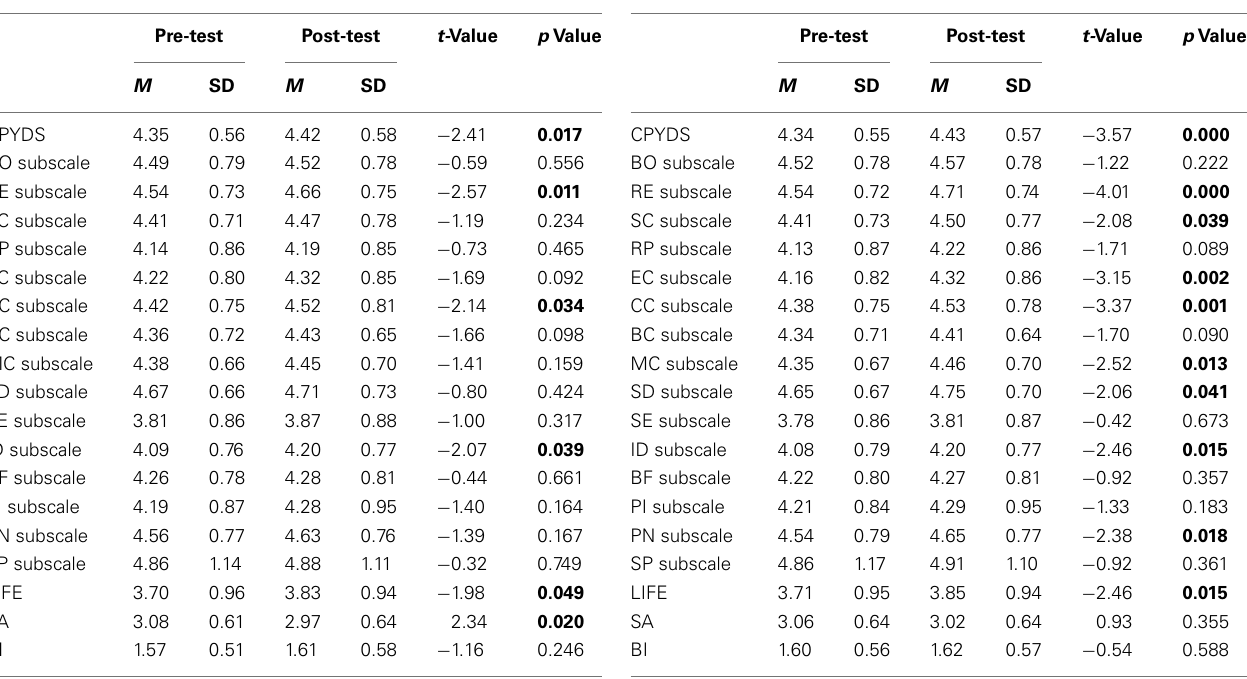
Table 8 |The changes of all participants based on the different objective indicators ( n = 236)